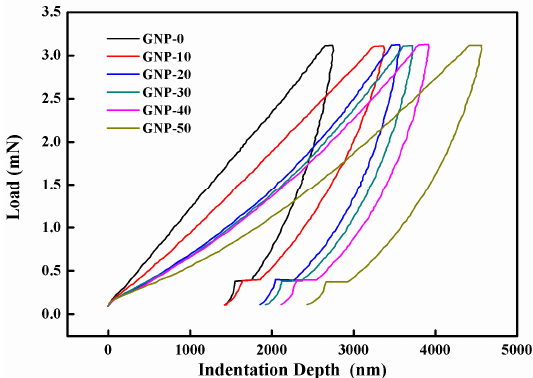
Figure 9. Load versus indentation depth curves for the hybrid films with different weight percentages of GNP.